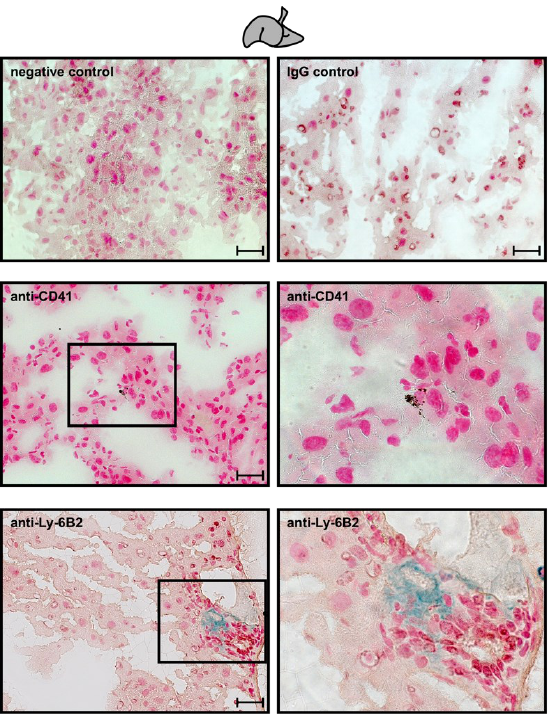
Figure A6. Immunohistological staining of infarcted liver tissue . Structural staining of organ cells was achieved by nuclear fast red. Immunohistological isotype and secondary antibody control staining (nuclear fast red stained without anti-CD41 or anti-Ly-6B2). Scale bars 10 µm. Representative single staining of platelets (anti-CD41) and neutrophils (anti-Ly-6B2), as indicated. Right panels are 2.5× magnifications of the corresponding left panels . Representative images of n = 3 mice are shown.